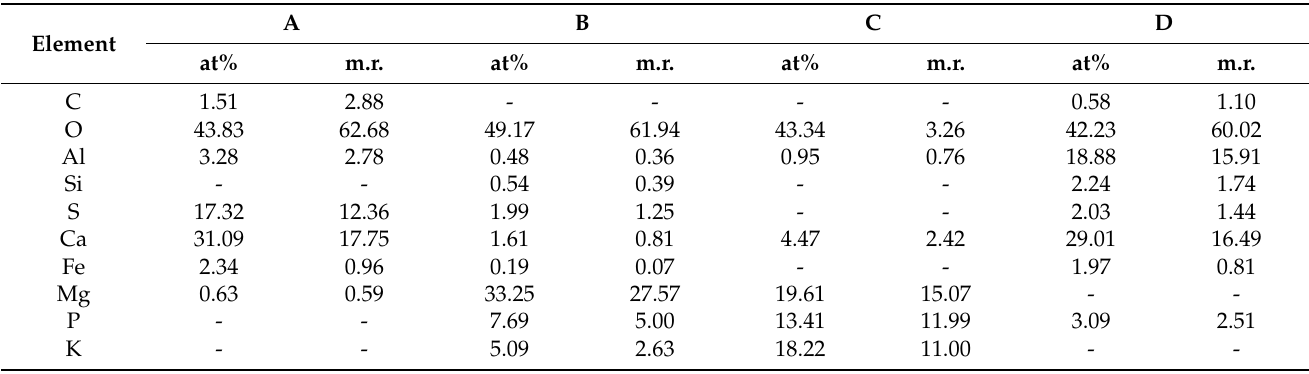
Table 6. Elemental distribution in selected